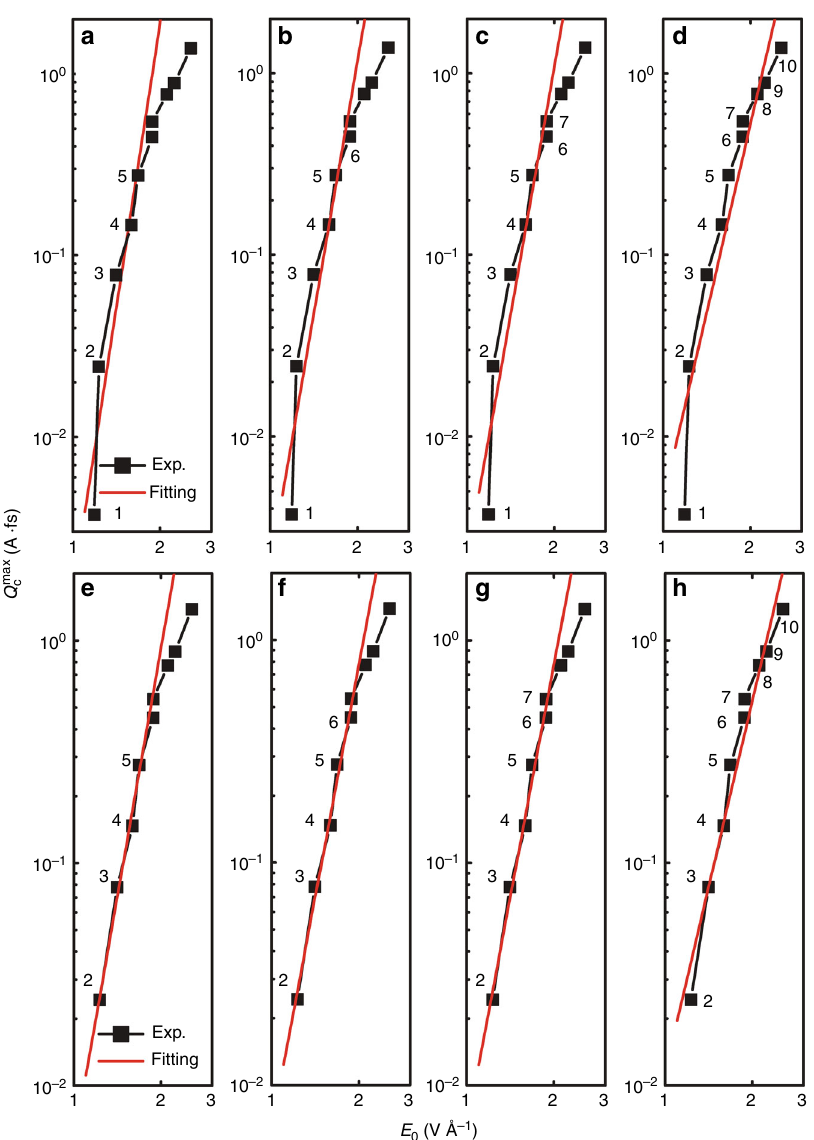
/ E j j r with applied laser fi eld amplitude. The different log – log plots correspond to Fig. 6 Scaling of the experimental maximum transferred charge Q max 0 c different fi ts that employ the sets of consecutive data points labeled in each panel. Different sets can capture different regimes in the laser matter interaction. The resulting power scaling r , quality of the least-square fi tting R 2 ≤ 1 and error Δ ½ r ; R 2 ð Δ Þ(cid:4) are as follows: a [10.4, 0.84 (21.2%)], b [9.2, 0.87 (17.3%)], c [9.0, 0.89 (13.9%)], d [6.9, 0.88 (12.4%)], e [7.4, 0.98 (8.5%)], f [6.9, 0.98 (6.9%)], g [7.0, 0.99 (5.3%)], h [5.5, 0.95 (8.1%)]. Data points 2 – 7 ( g ) correspond to a regime that is well characterized by a given order in the perturbative response of the system to the electric fi eld, and yield r = 7 ( R 2 = 0.99, Δ =